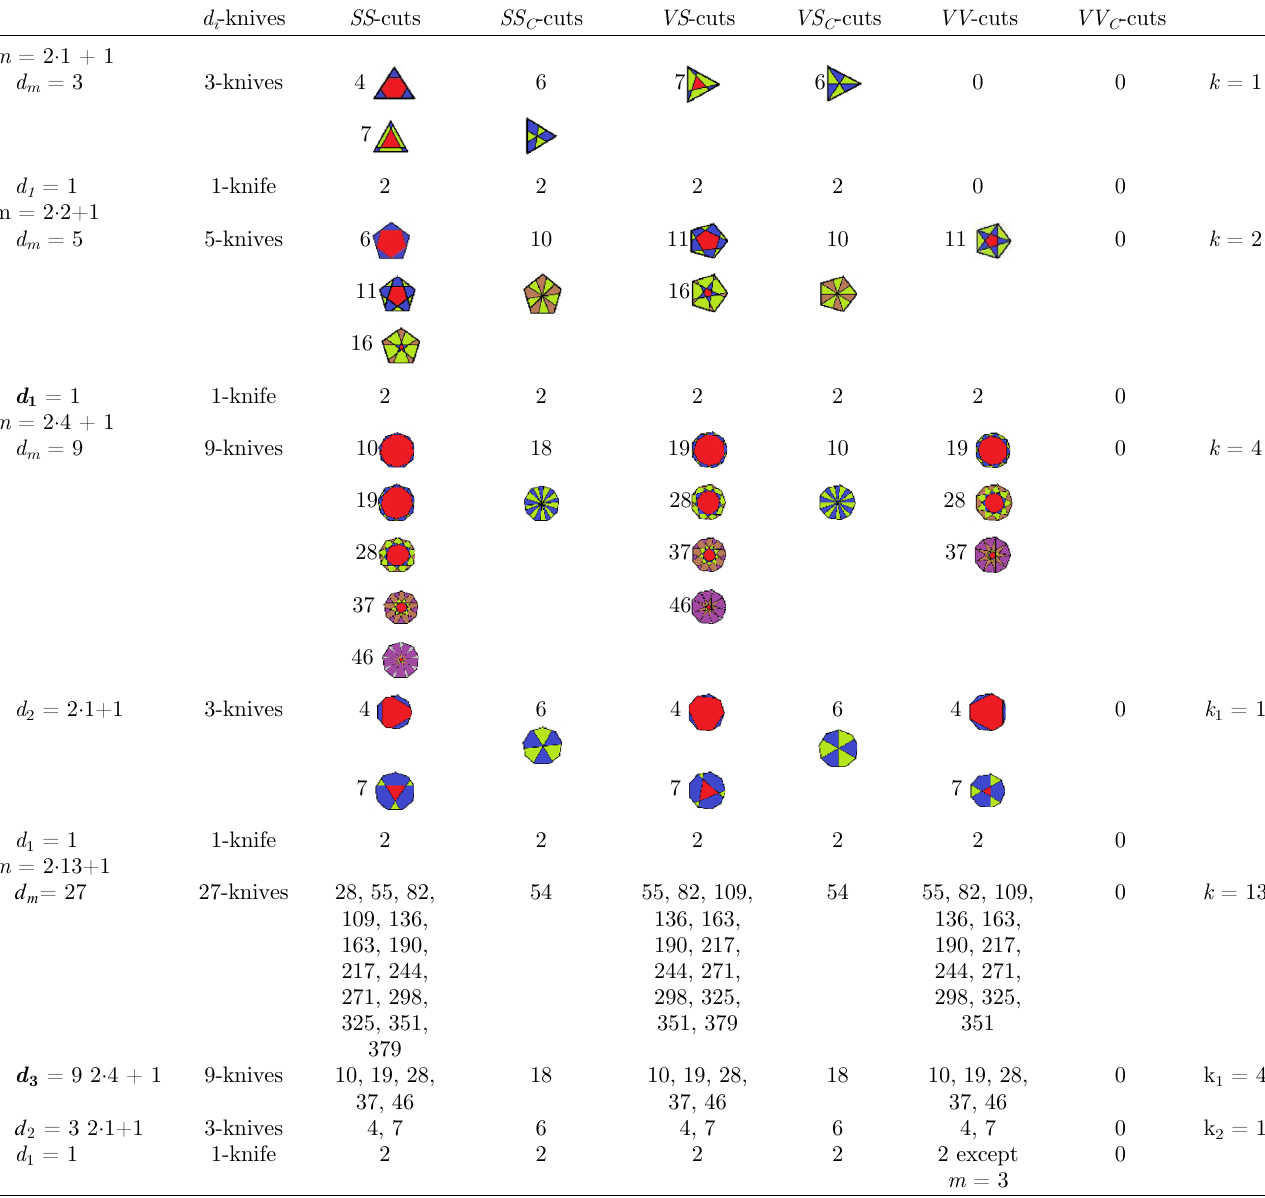
bodies for odd m = 3, 5, 9, m